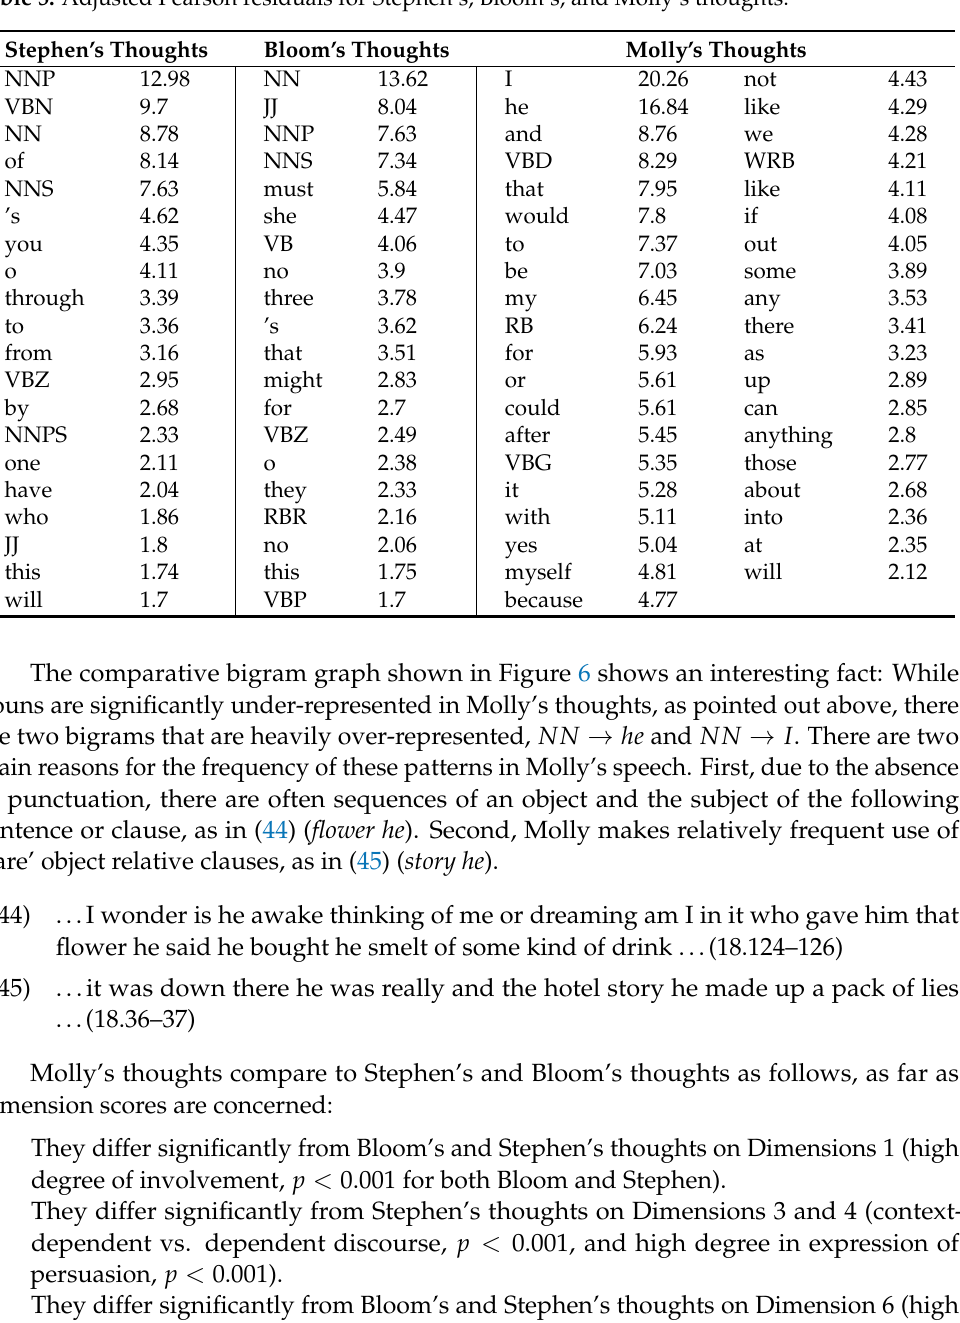
Table 5. Adjusted Pearson residuals for Stephen’s, Bloom’s, and Molly’s